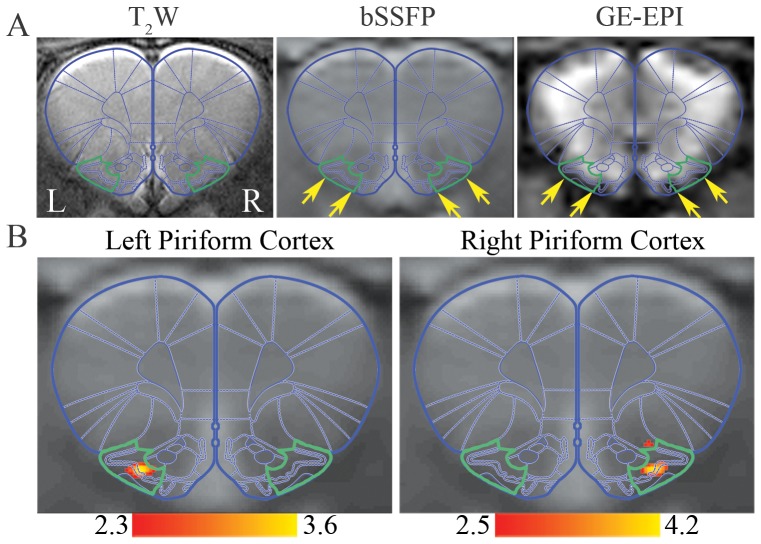
A distortion-free RSN derived from bSSFP images at rat piriform cortex (PC).
A: T2W RARE, bSSFP and GE-EPI images at identical slice location covering PC. PCs were overlaid by green contours based on atlas [49]. Note that GE-EPI suffered from image distortion and signal dropout at inferior and lateral PCs as pointed by arrow heads, while bSSFP was in good agreement with T2W image. B: Unilateral RSNs for left and right PCs derived from bSSFP. PC, Bregma 3.3 mm.